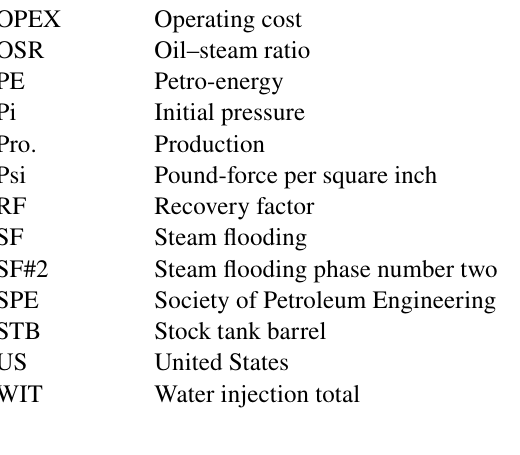
Fig. 1 FNE location map (Elbaloula et al.